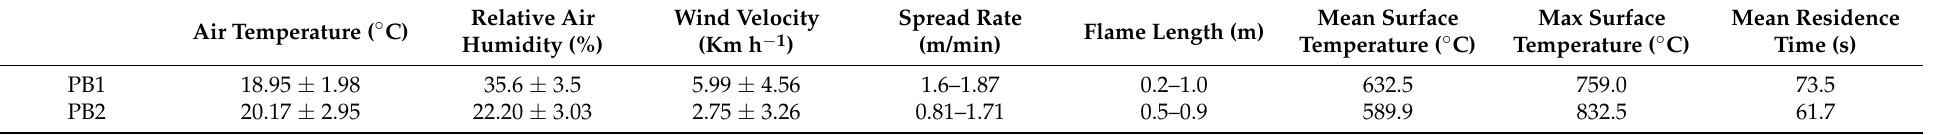
Table 1. Prescribed burns main characteristics (Data provided by INFOCA and